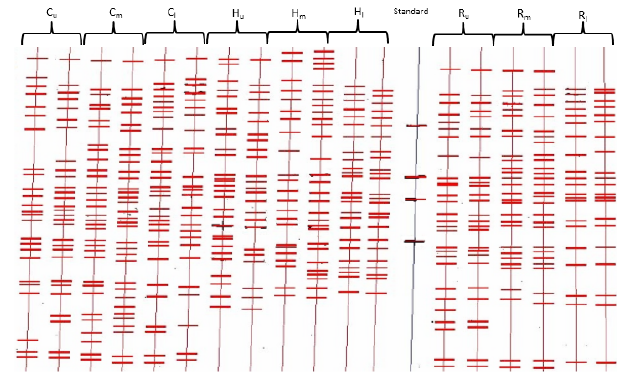
Figure 3. SSCP profiles of the bacterial communities of soil sam- pled from columns C (uncontaminated soil), H (contaminated by the raw waste containing oily compounds and radionuclides), and R (contaminated by treated waste containing mainly radionuclides) in different layers [upper (0–20cm; u ), middle (20–40cm; m ), and lower (40–60cm; l )].